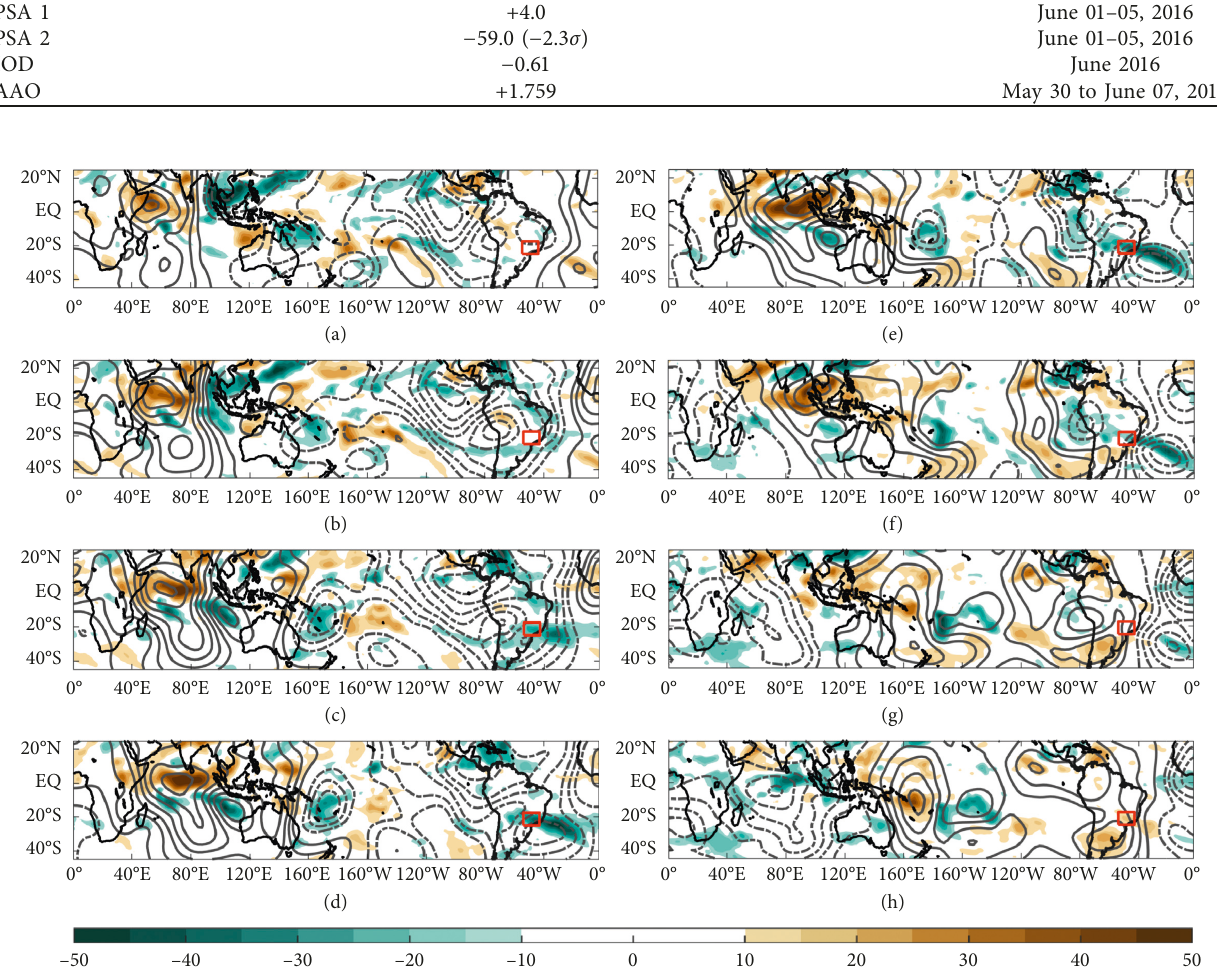
2 ; shaded) and sigma-level 0.21 velocity potential (black contours every m · −